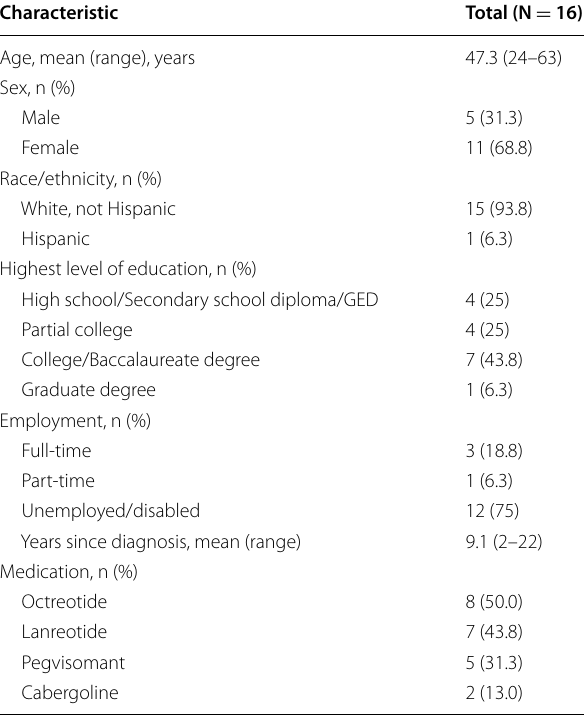
Table 1 Participant characteristics for the concept elicitation and cognitive debriefing